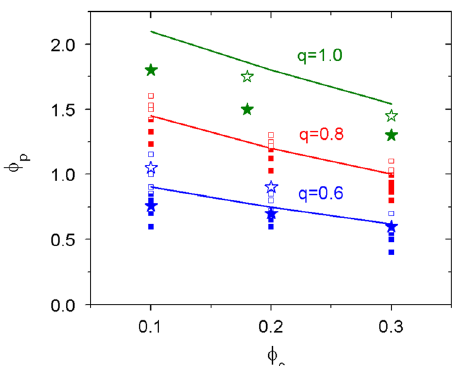
Fig. 3 The ϕ c − ϕ p phase diagram showing the regions where the disordered ( open symbols ) and the HCP structure ( fi lled symbols ) are obtained from bulk simulations. The blue and red symbols represent simulations with chain length M = 10 and 20, corresponding to the colloid-polymer aspect ratio q ~ 0.6 and 0.8, respectively. Boundaries predicted by the density functional theory are marked by the solid lines for chain length of 10 ( blue ), 20 ( red ) and 40 ( green ). The “ gelation ” boundaries adopted from Ref. [7] for corresponding q values are also included for comparison: open stars are the gel phase while fi lled stars are